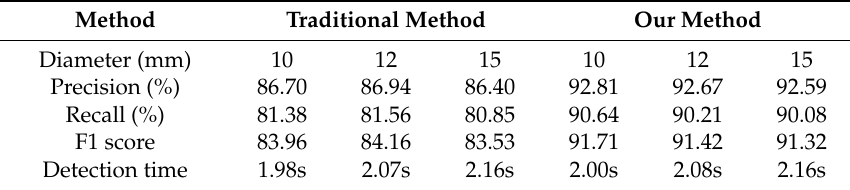
Table 12. Comparison between the traditional method and our